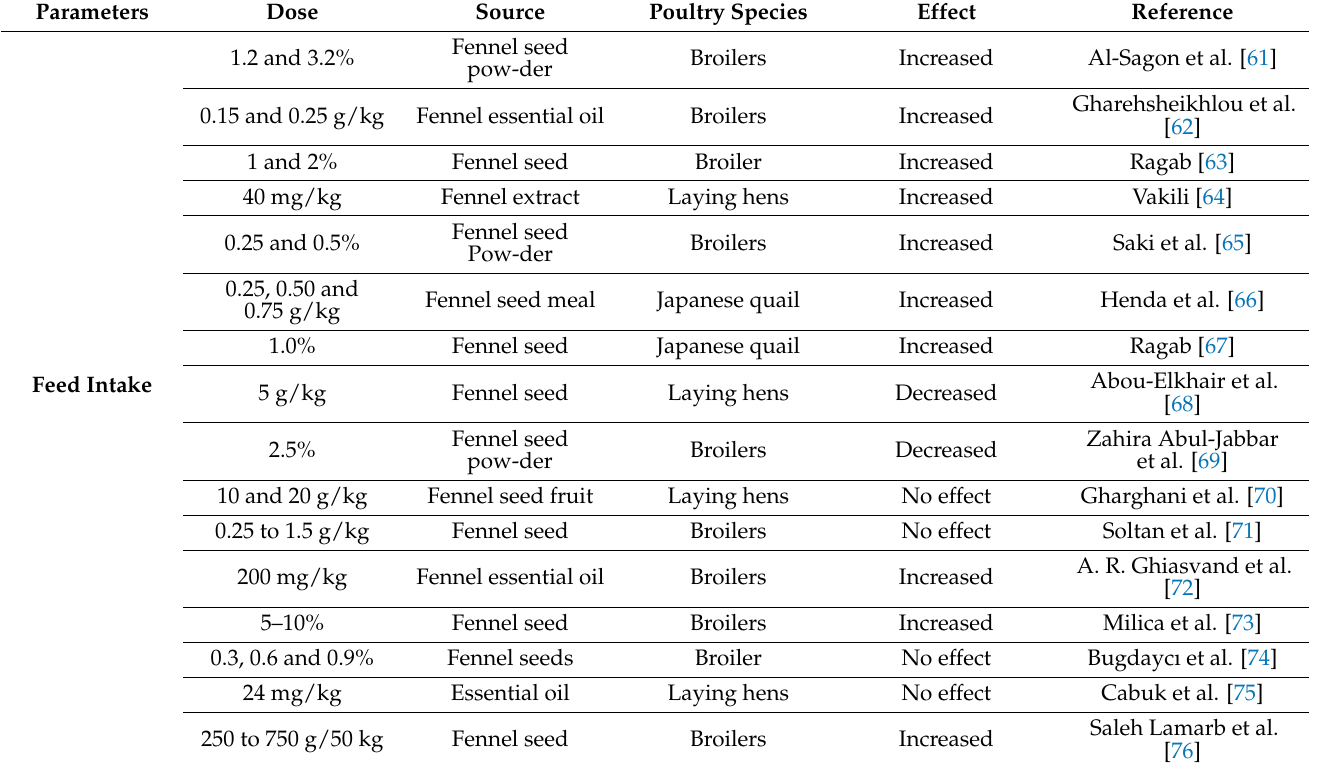
Table 3. Reported beneficial effects of fennel in